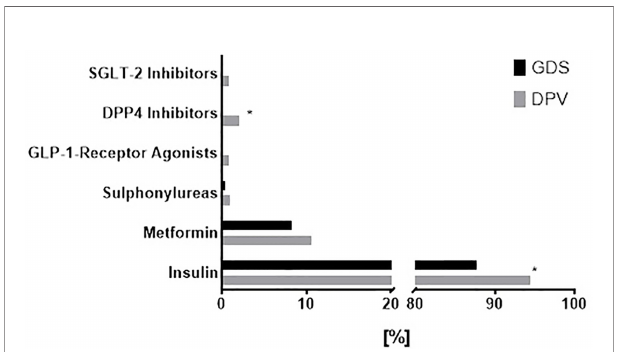
FIGURE 4 | Prevalence and management of hypertension and dyslipidemia in patients with newly diagnosed type 1 diabetes strati fi ed by sex. Prevalence and management of modi fi able cardiovascular risk factors (dyslipidemia and hypertension) in males (blue) and females (red) with newly diagnosed type 1 diabetes from the GDS and DPV cohort. ‘ Treated ’ refers to the frequency of lipid- lowering medication or antihypertensive, respectively. Data are expressed as percent from the total number of measured participants in each cohort. P values refer to comparison of unadjusted data. *p < 0.05 regarding the prevalence of comorbidities.